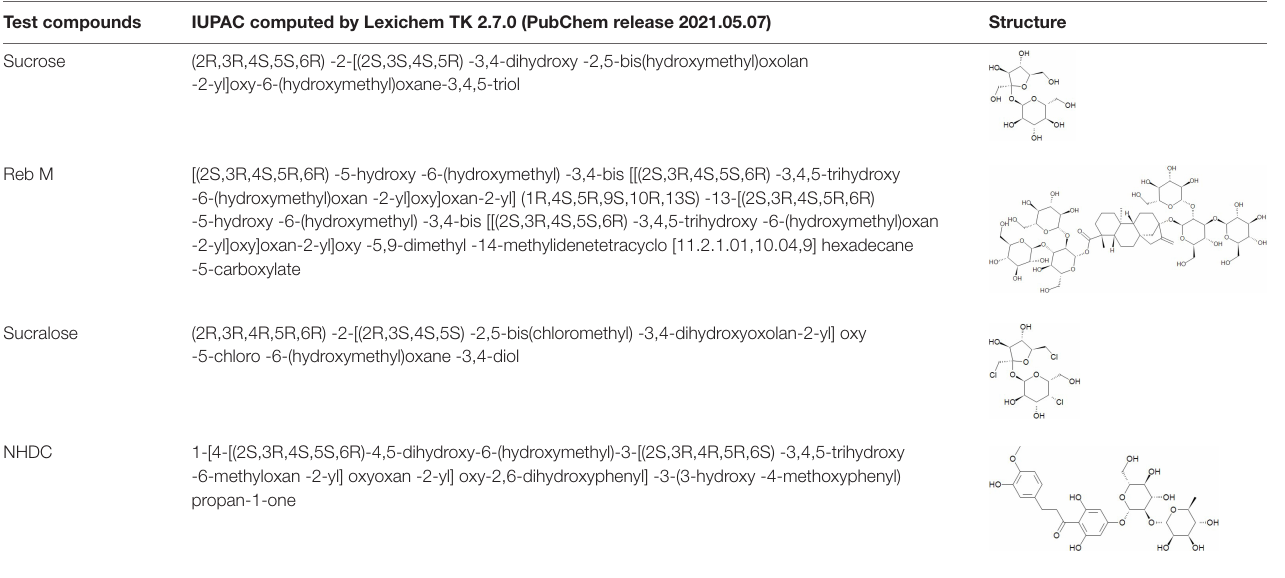
TABLE 1 | IUPAC names and chemical structures of the test compounds. Test